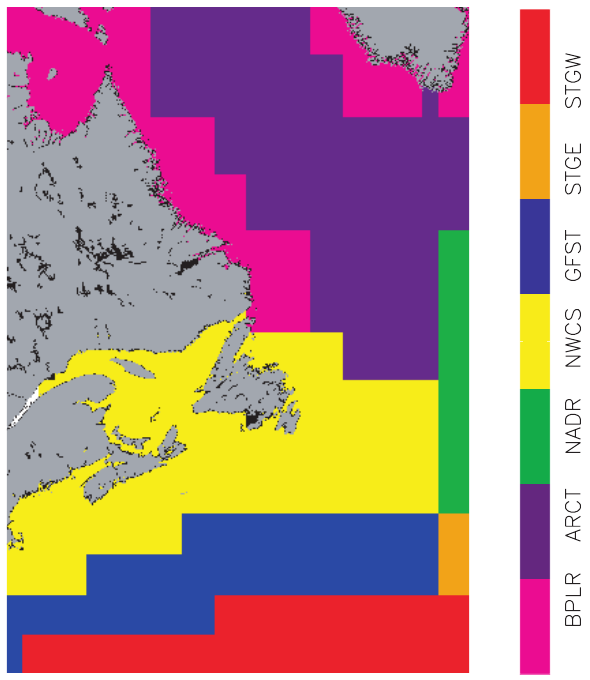
Fig. 5. – The ecological provinces in the North-West Atlantic as defined by Sathyendranath et al .